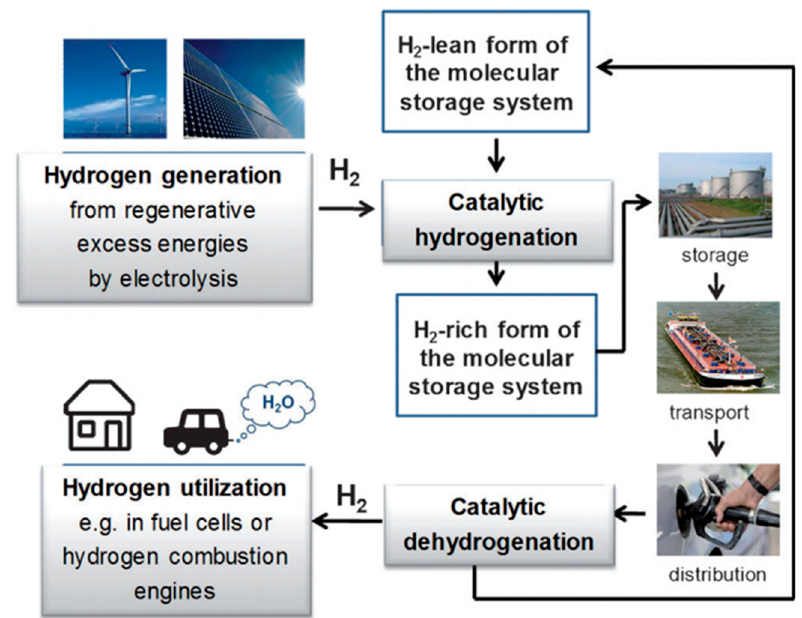
Scheme 1. Schematic representation of H 2 -based concepts of chemical energy storage and transport using existing distribution infrastructure; copyright (2014), ChemPubSoc Europe.